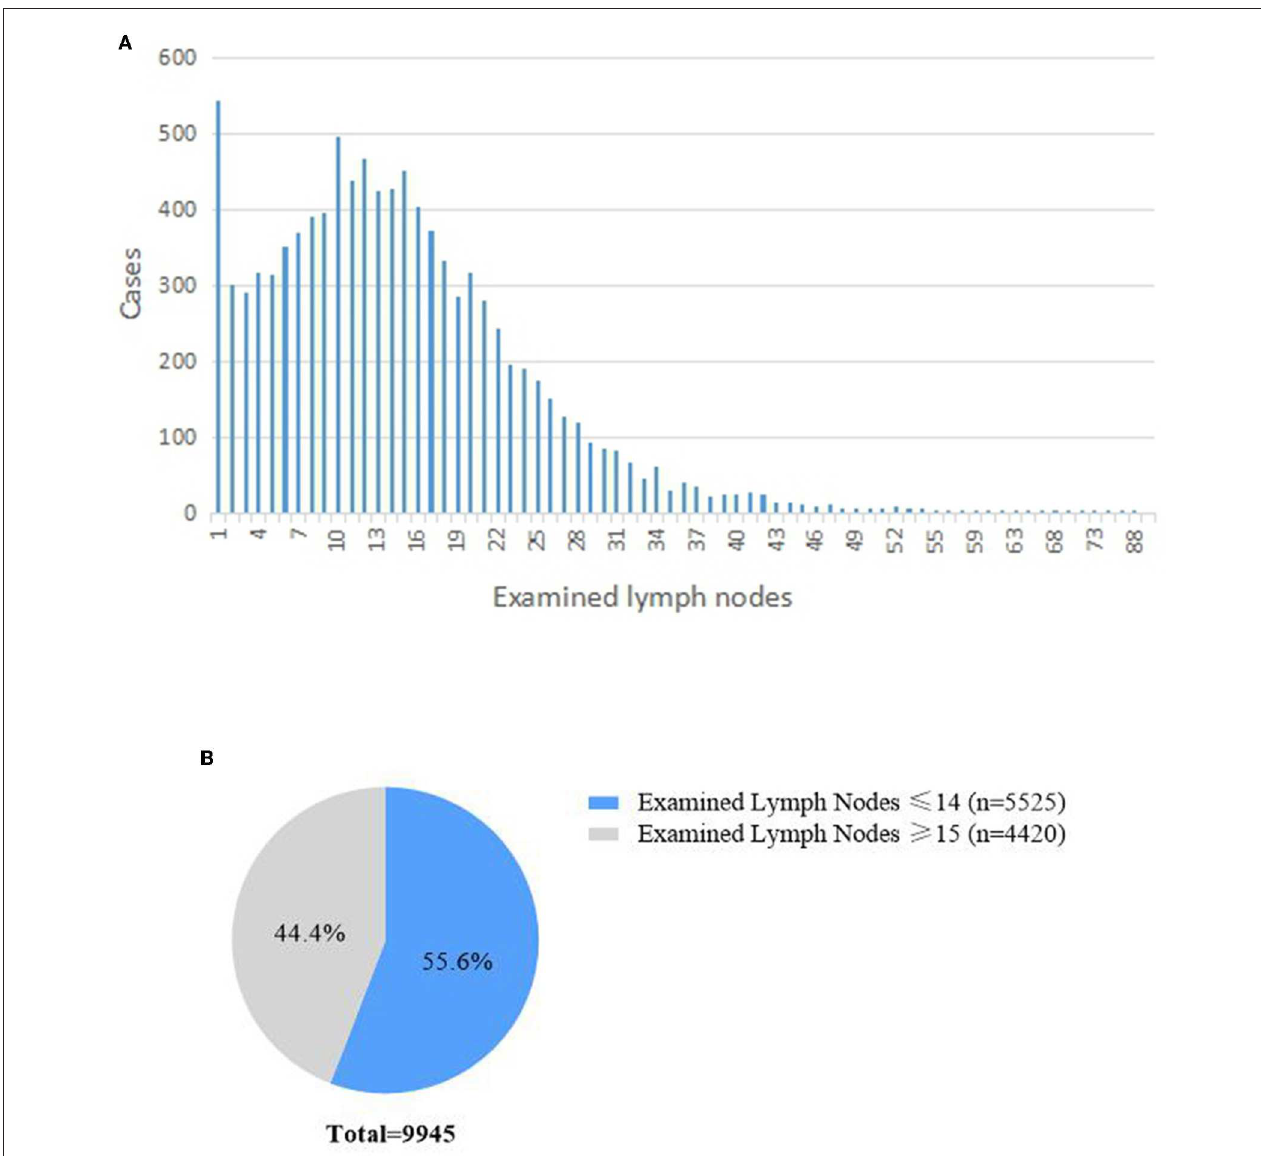
FIGURE 1 | The distributions of the examined lymph